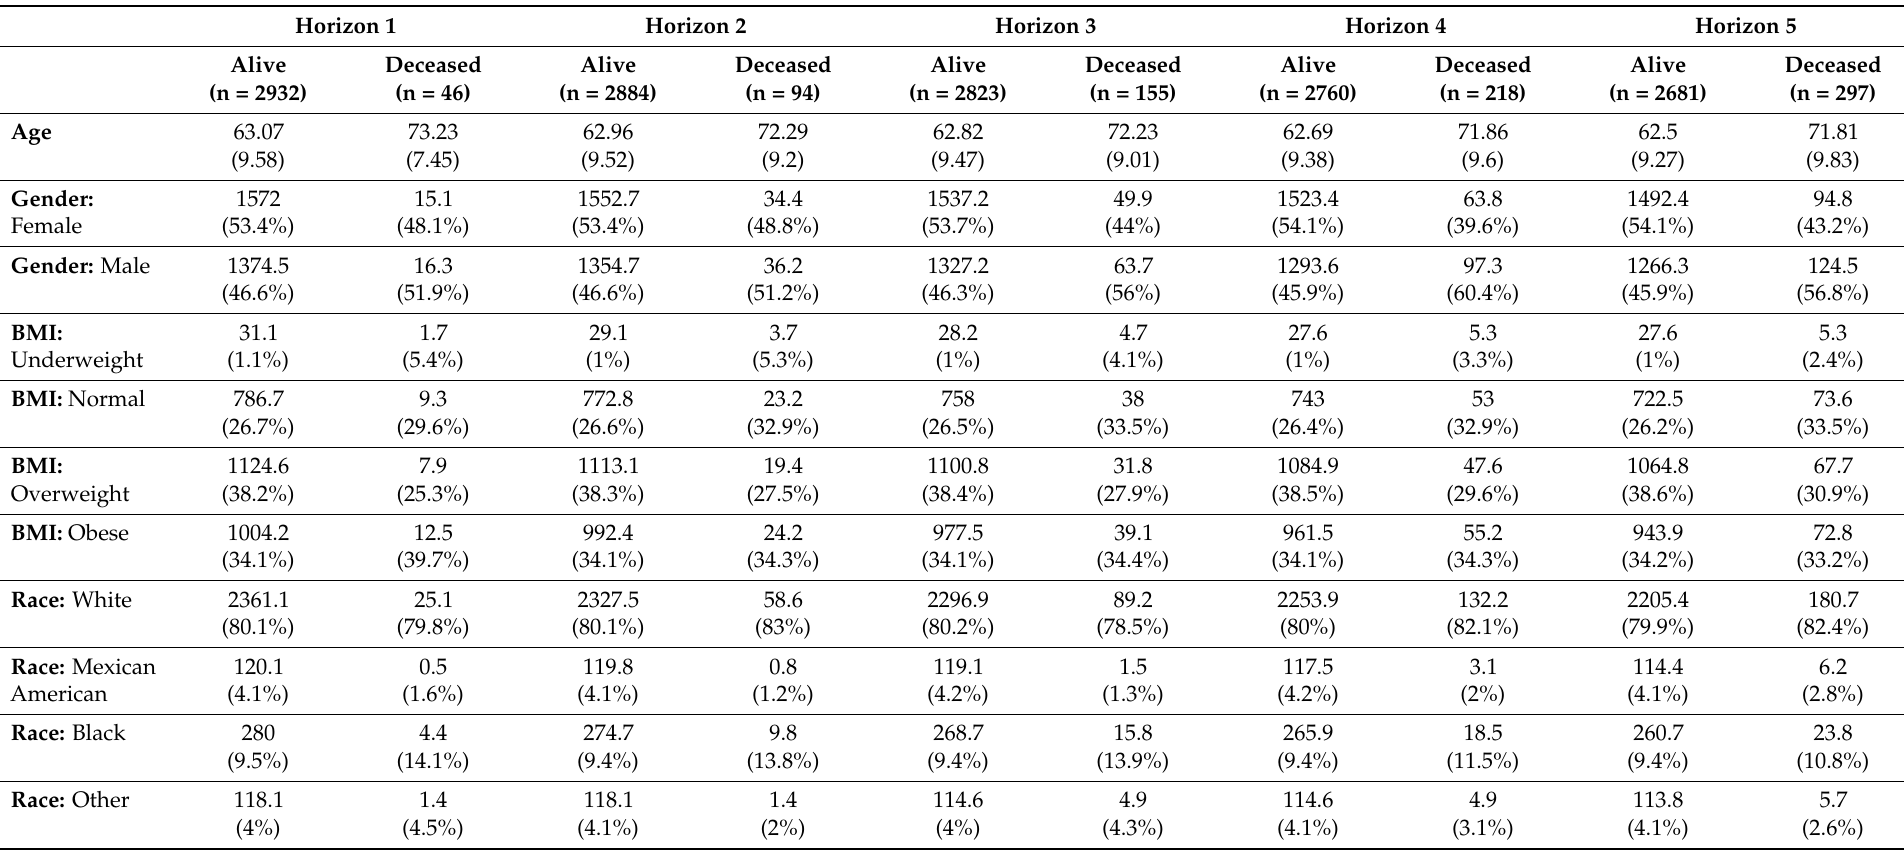
Table 1. Unadjusted number of alive and diseased participants and complex-survey adjusted demographic characteristics separated by alive and deceased status for 1-, 2-, 3-, 4-, 5-years after the participation in the accelerometry study in NHANES 2003–2006 cohorts. For each prediction horizon, the unadjusted number of participants is calculated as the total number of participants who were alive and deceased one, two, three, four and five years after participating in the study. The complex survey weighted number of participants in each category is calculated as the sum of all adjusted sampling weights for all participants in that